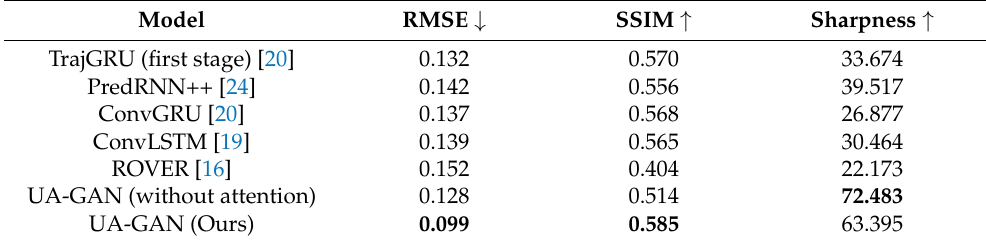
Table 9. Image quality comparisons of radar echo prediction. Model RMSE ↓ SSIM